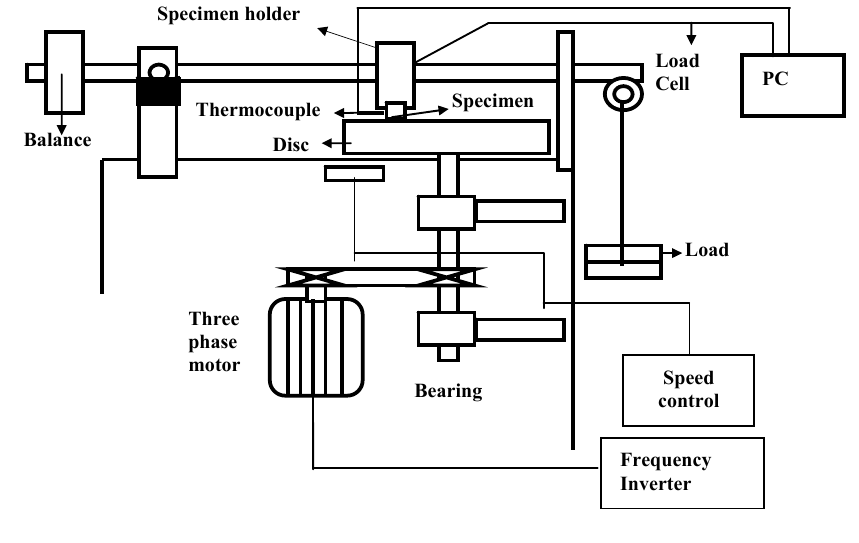
Figure 1. Pin-on-disc wear tester